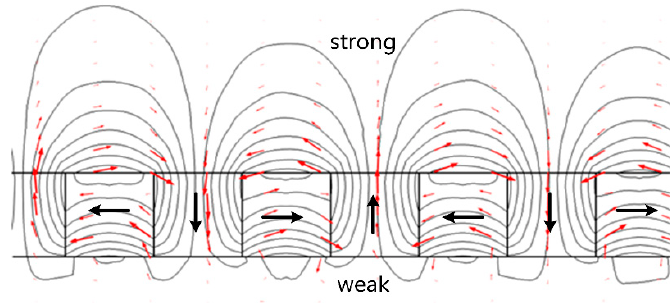
Figure 2. The flux distribution of the quasi-Halbach array.